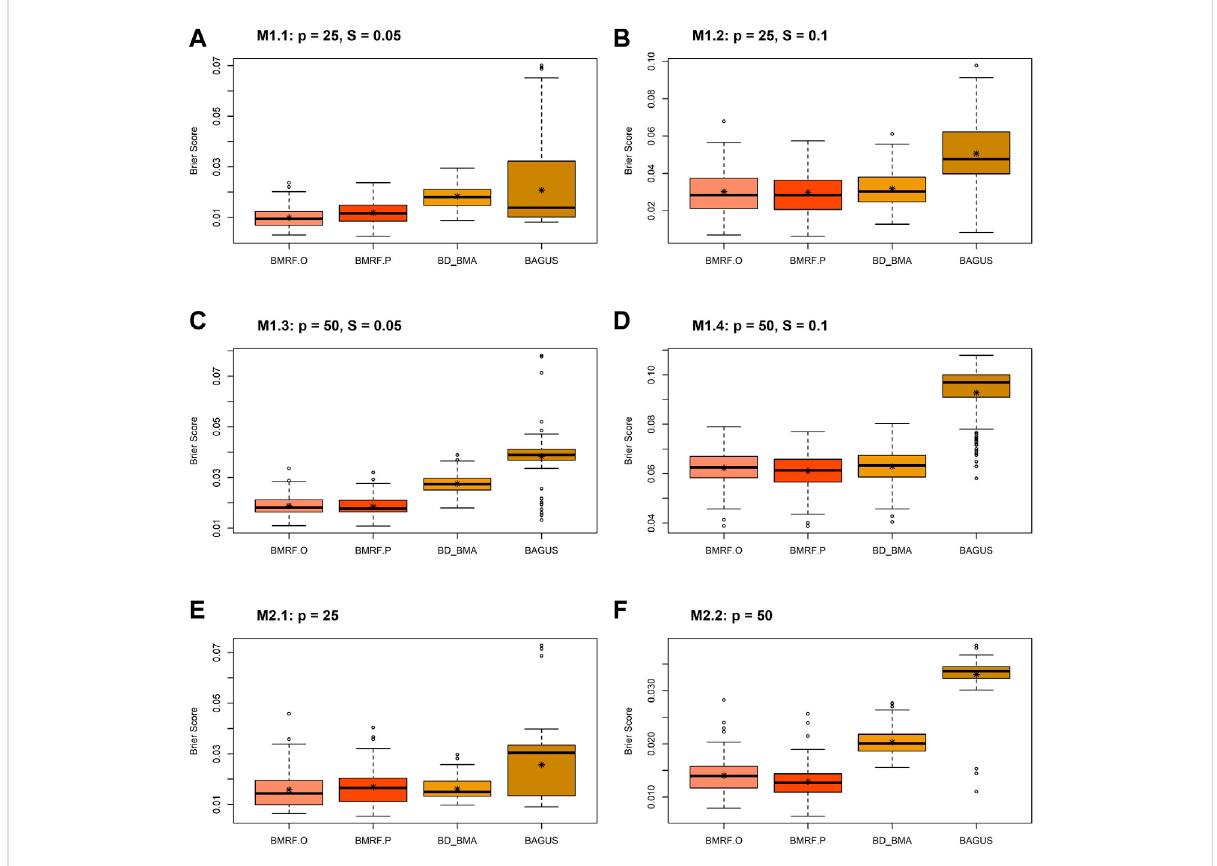
FIGURE 3 Boxplots of the Brier scores of the four Bayesian estimates, BMRF.O, BMRF.P, BD_BMA, and BAGUS, under six different simulation settings: (A) M1.1; (B) M1.2; (C) M1.3; (D) M1.4; (E) M2.1; (F)